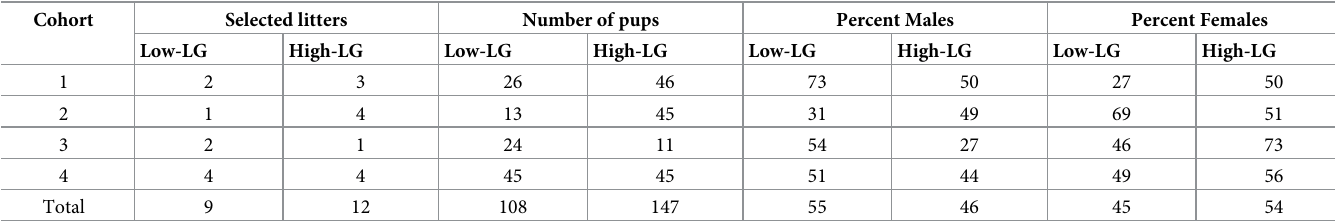
Table 2. Number of litters and pups used in developmental tracking and functional/structural